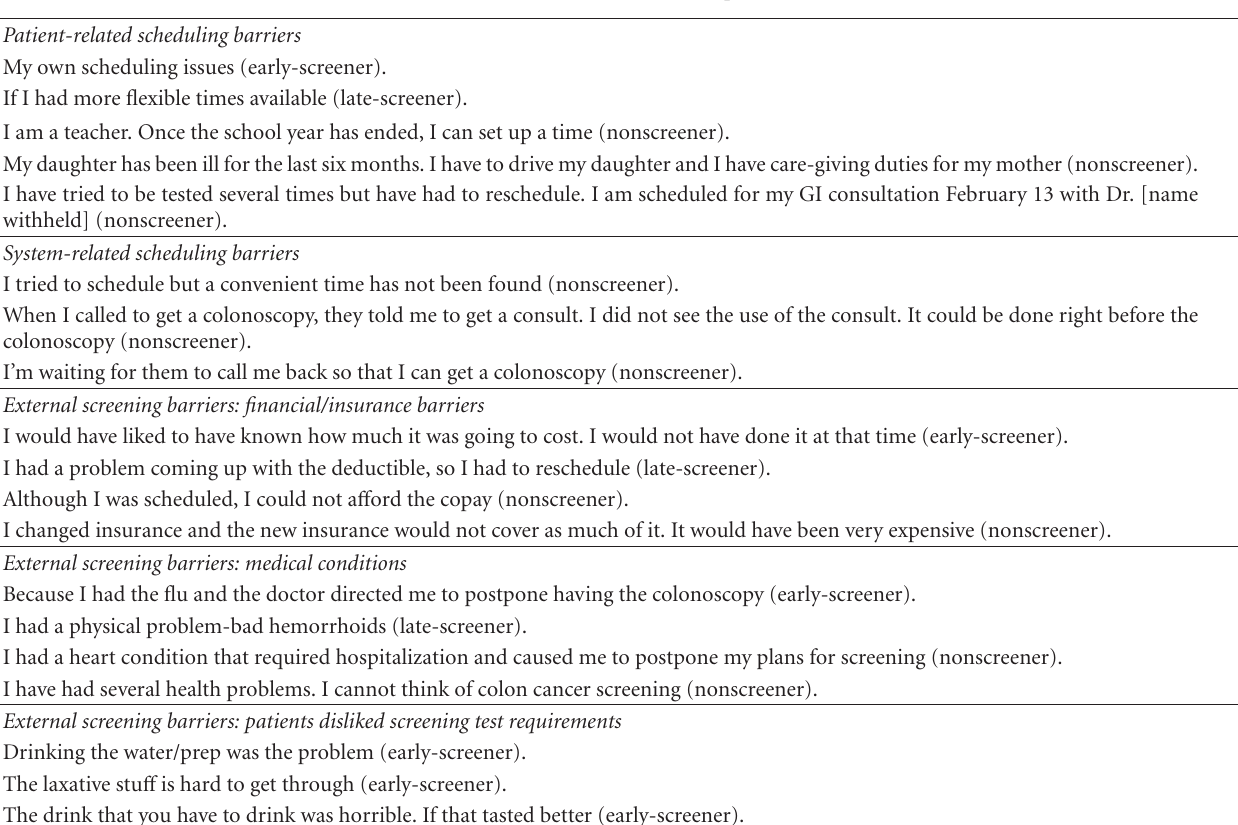
Table 3: Selected illustrative